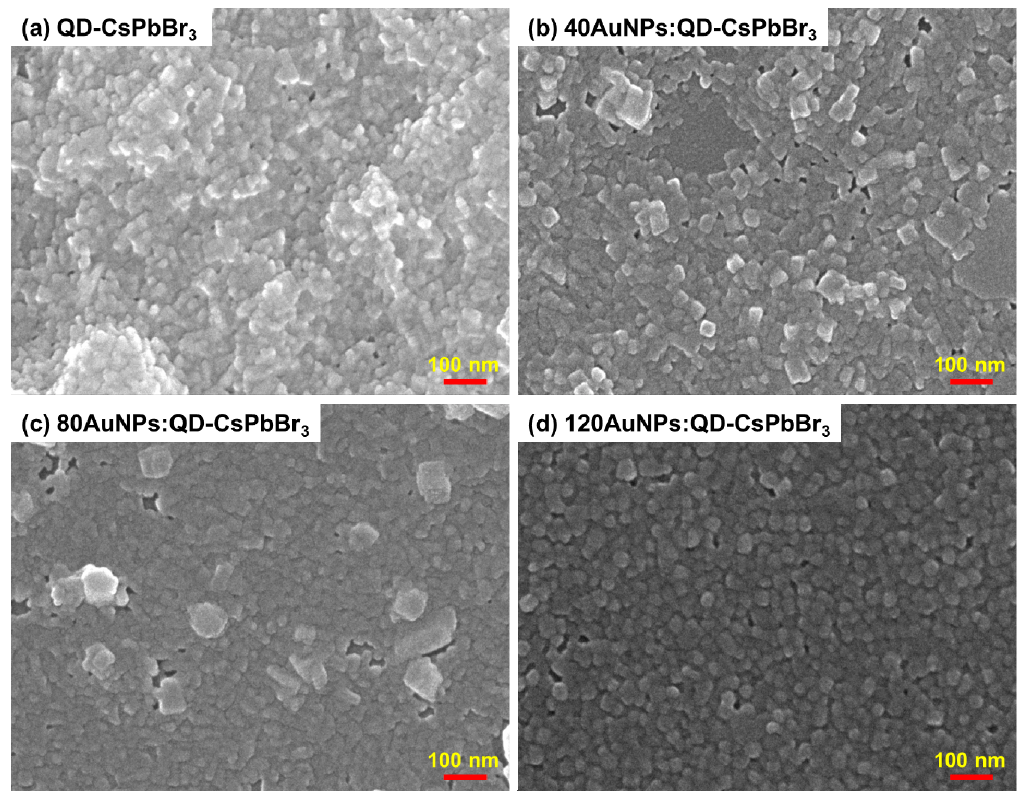
Figure 3. Top-view SEM images of annealed ( a ) QD-CsPbBr 3 , ( b ) 40AuNPs:QD-CsPbBr 3 , ( c ) Figure3. Top-viewSEMimagesofannealed( a )QD-CsPbBr 3 ,( b )40AuNPs:QD-CsPbBr 3 ,( c )80AuNPs:QD- 80AuNPs:QD-CsPbBr 3 and ( d ) 120AuNPs:QD-CsPbBr 3 . CsPbBr 3 and ( d ) 120AuNPs:QD-CsPbBr 3